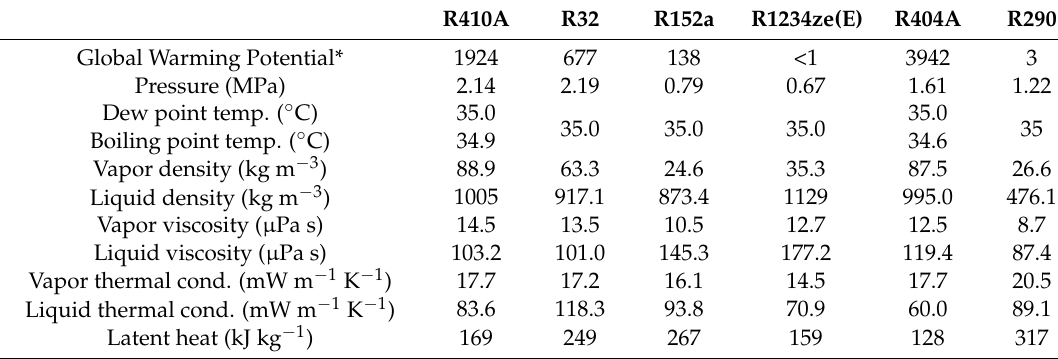
Table 2. Physical properties of used refrigerants at saturation state temperature 35 ◦